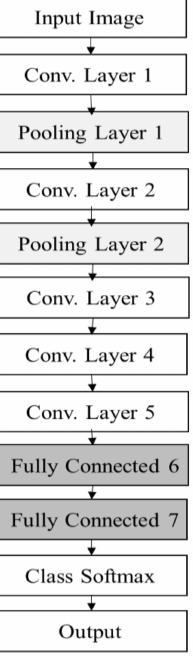
Figure 8. The architecture of ZFNet [43].